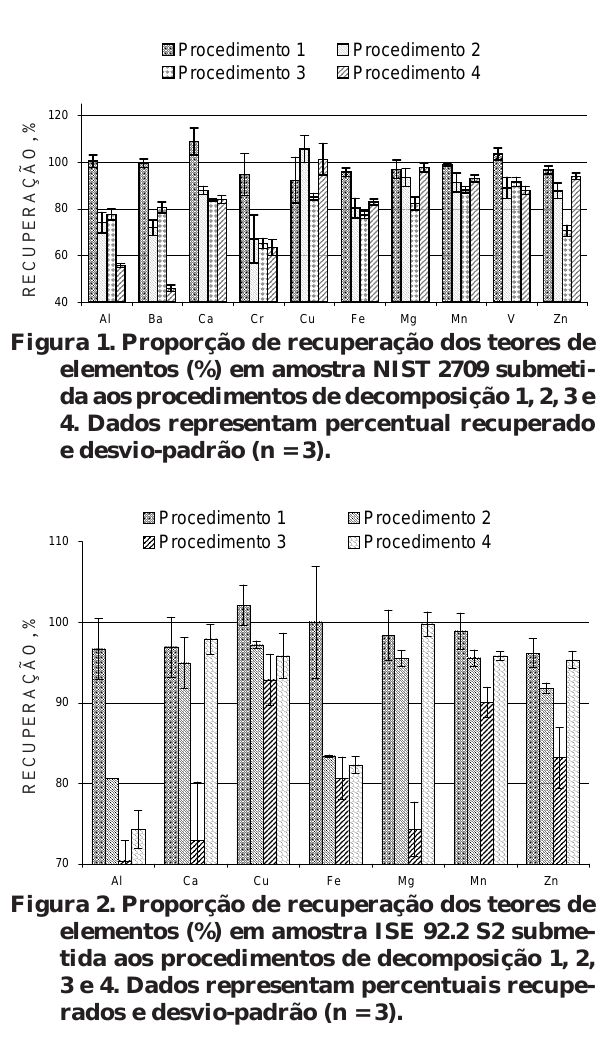
Figura 2. Proporção de recuperação dos teores de elementos (%) em amostra ISE 92.2 S2 subme- tida aos procedimentos de decomposição 1, 2, 3 e 4. Dados representam percentuais recupe- rados e desvio-padrão (n =